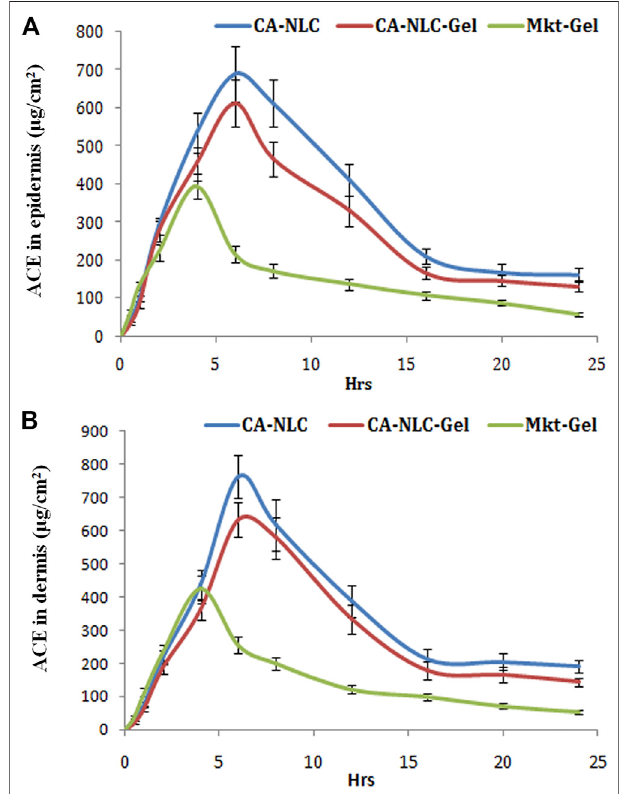
FIGURE 8 | Quanti fi cation of ACE in the (A) epidermis and (B) dermis (ug/cm 2 ) with CA-NLCs, CA-NLC-gel, and Mkt-gel.